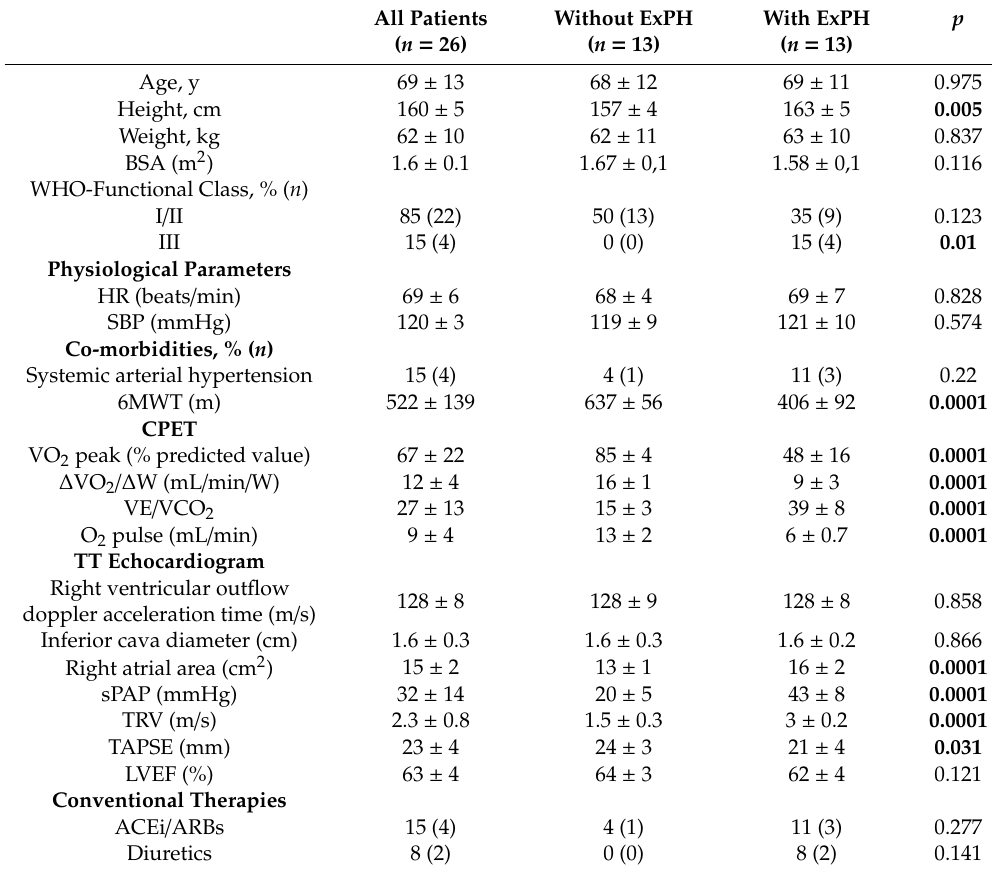
Table 2. Baseline characteristics of the study